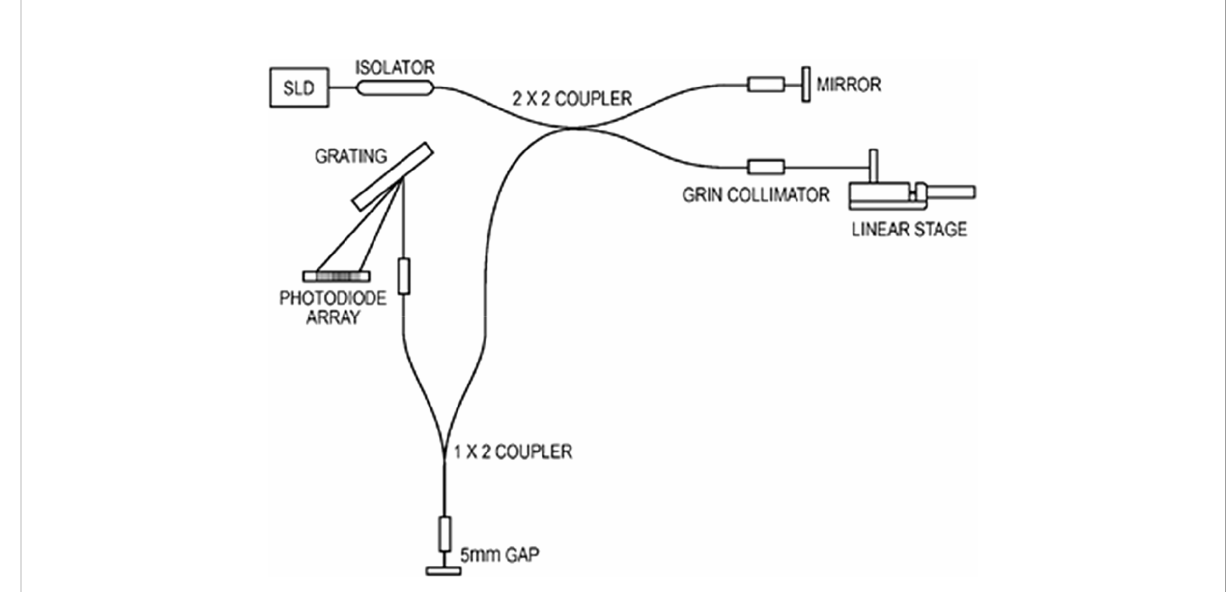
FIGURE 9 Scheme of the interferometer patented by Kapit et al. (2016).